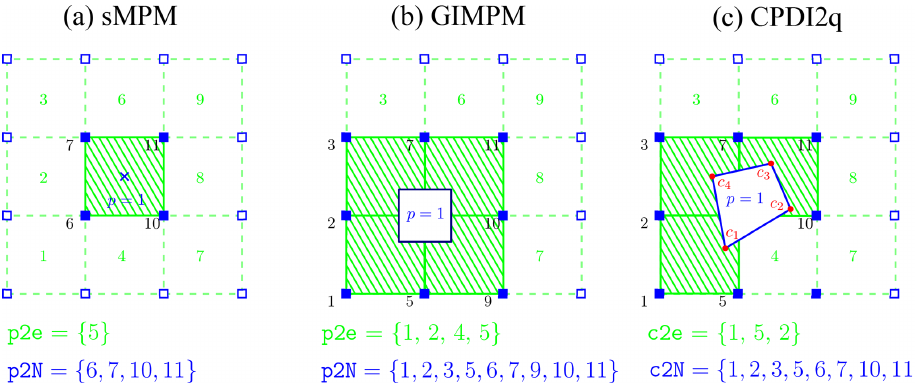
Figure 2. Nodal connectivities of the (a) standard MPM, (b) GIMPM and (c) CPDI2q variants. The material point’s location is marked by the blue cross. Note that the particle domain does not exist for sMPM (or BSMPM), unlike GIMPM or CPDI2q (the blue square enclosing the material point). Nodes associated with the material point are denoted by filled blue squares, and the element number appears in green in the centre of the element. For sMPM and GIMPM, the connectivity array between the material point and the element is p2e , and the array between the material point and its associated nodes is p2N . For CPDI2q, the connectivity array between the corners (filled red circles) of the quadrilateral domain of the material point and the element is c2e , and the array between the corners and their associated nodes is c2N